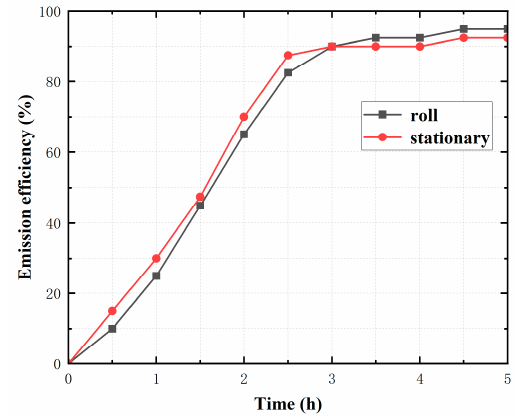
Figure 23. Comparison of particle emission effect.